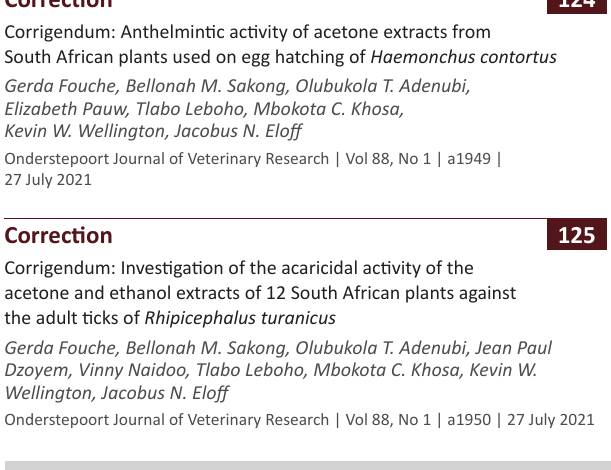
Corrigendum: Acaricidal activity of the aqueous and hydroethanolic extracts of 15 South African plants against Rhipicephalus turanicus and their toxicity on human liver and kidney